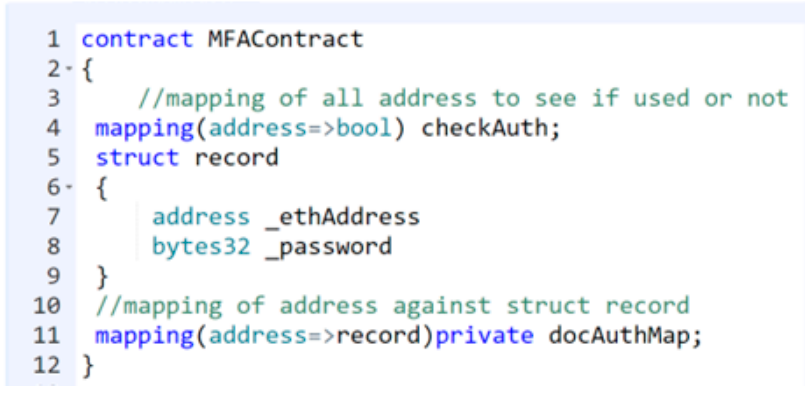
Figure 13. Confirmation window during the registration transaction using Metamask Wallet.